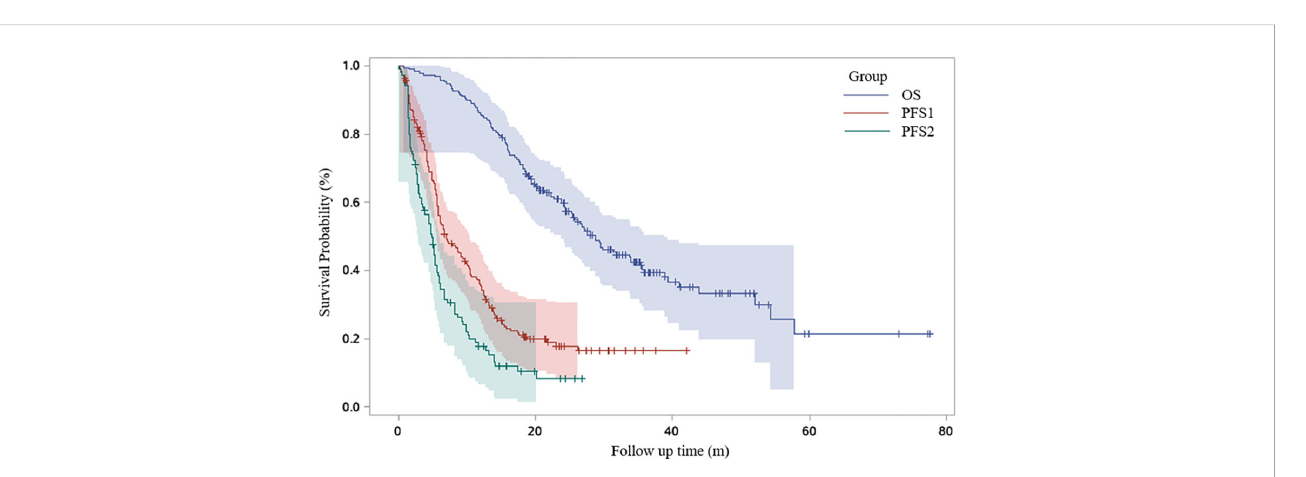
FIGURE 1 Kaplan-Meier curves for OS, PFS1 and PFS2 of the entire